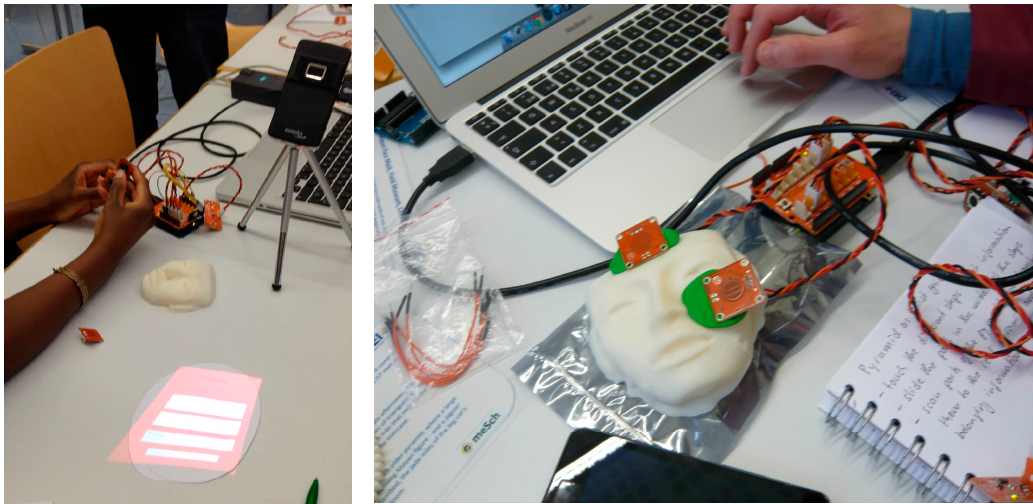
Figure 12. Physical buttons ( left ) and touch sensors ( right ) are used to interact with a 3D replica of a funerary mask.